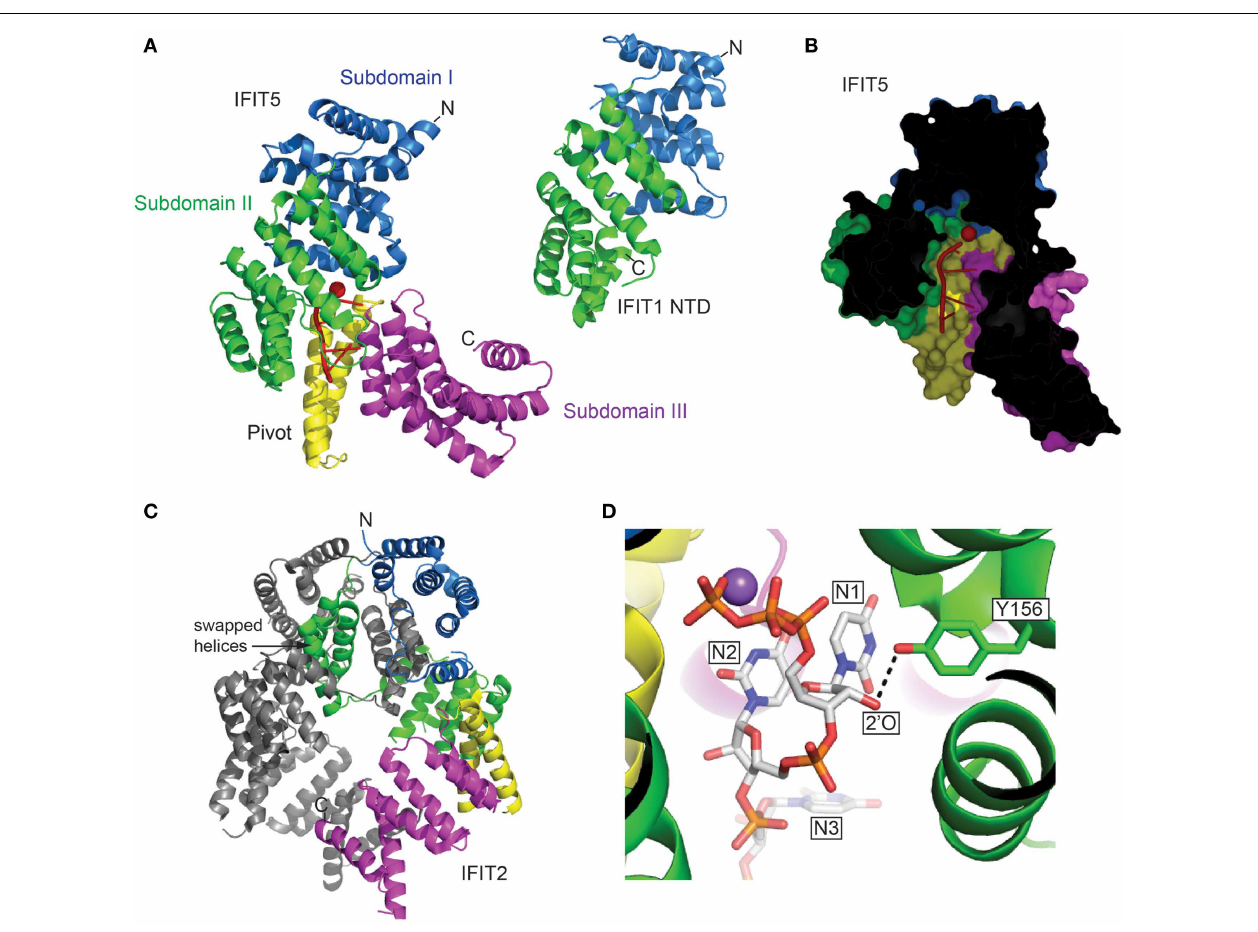
entry 4G1T) colored according to the corresponding IFIT5 subdomains. Indicated are helices 7–9 that are swapped with the other protomer. (D) The Y156 of IFIT5 forms a hydrogen bond (dotted line) with the 2 (cid:48) - O of the first ribose (IFIT5 in complex with oligoU, PDB entry 4HOS). Metal ions are depicted as spheres (Red, Mg 2 + ; Purple, Na 2 +